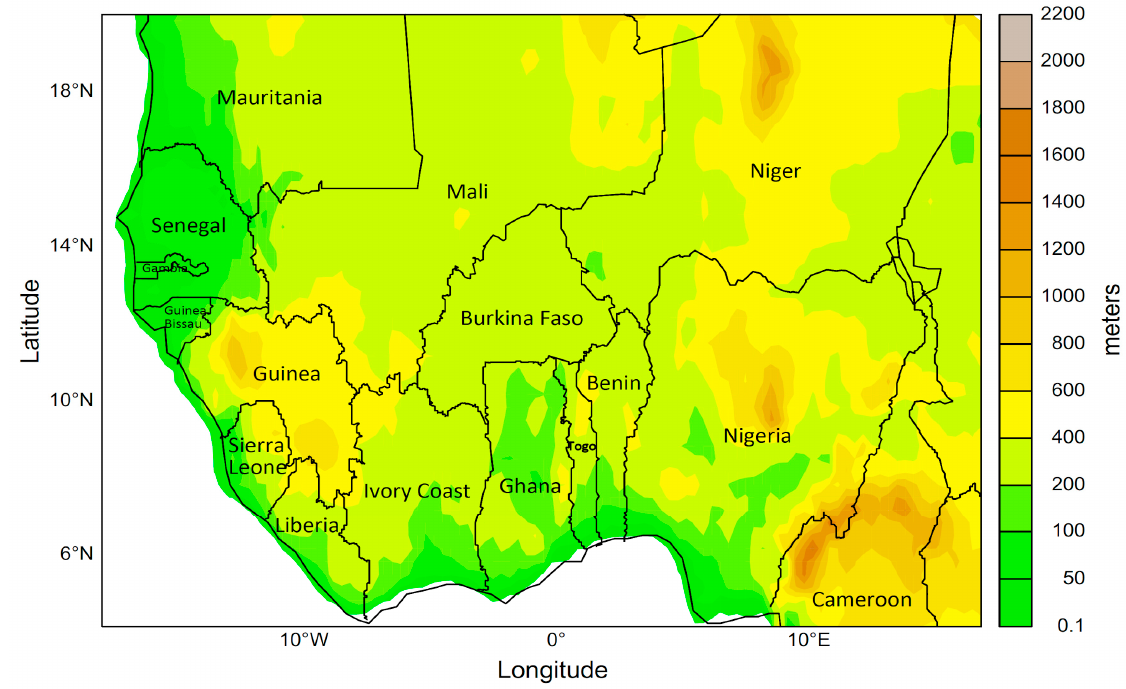
Figure 1. A map of West Africa showing topography and countries. Dark brown areas denote mountainous regions.